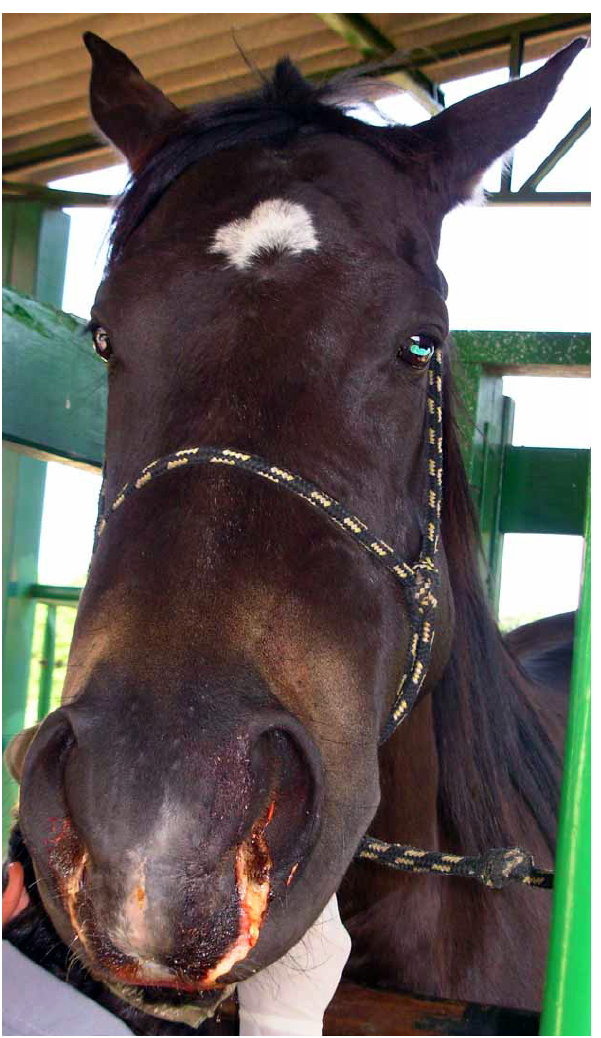
Figure 2 . Severe edema on the muzzle of the first horse.